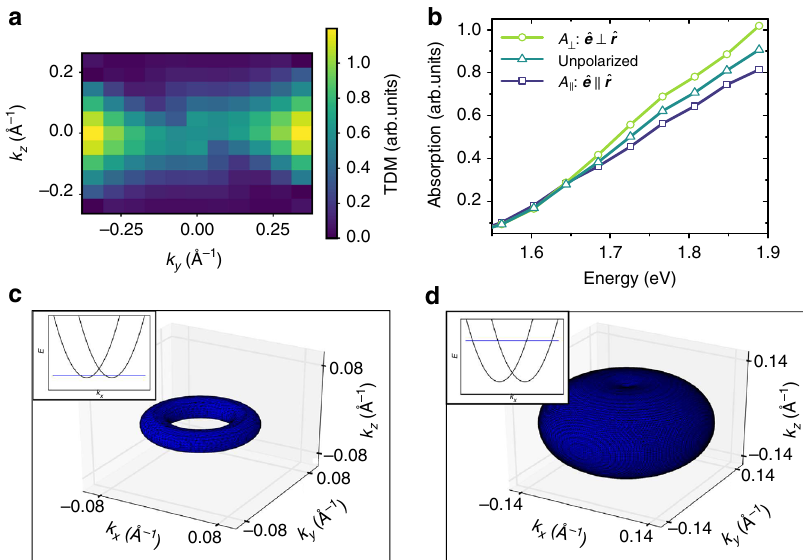
Fig. 6 First-principles calculation of transition dipole moments (TDMs). a Plot of the TDM k -space asymmetry for energies close to the band minima. b Calculated absorption spectrum from fi rst principles for electric fi eld polarization direction ^ e parallel and perpendicular to the Rashba direction of the crystal lattice ^ r , and for unpolarized light. Iso-energetic surfaces of photoexcited carrier distributions for photon energies c above and d near the band edge. The insets show parabolic band disperisons and indictae the energies at which the iso-energetic k -space surfaces were